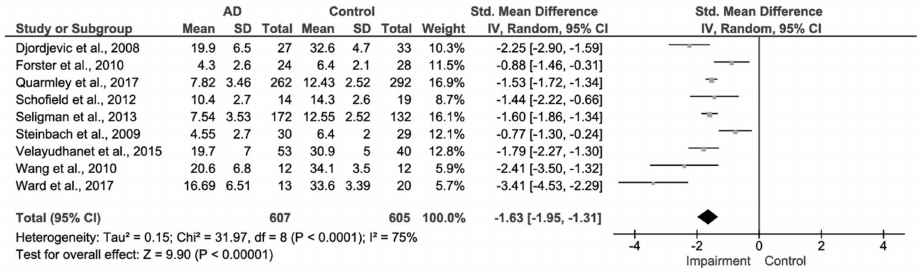
Figure 5. Forest plot comparing odour identification ability between AD and healthy control patients.